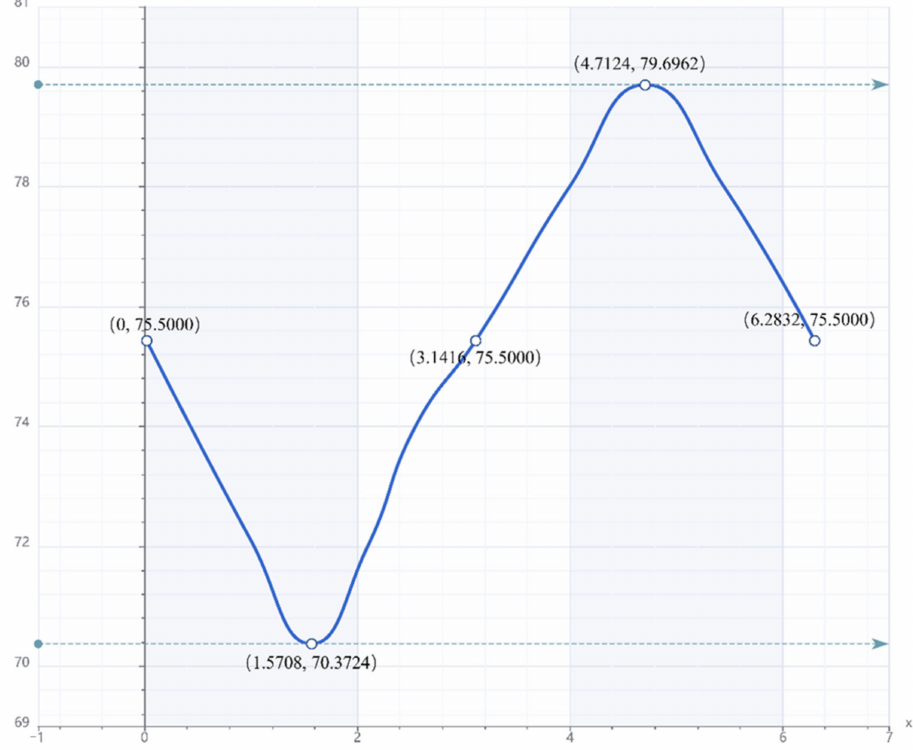
Figure 5. Cam profile